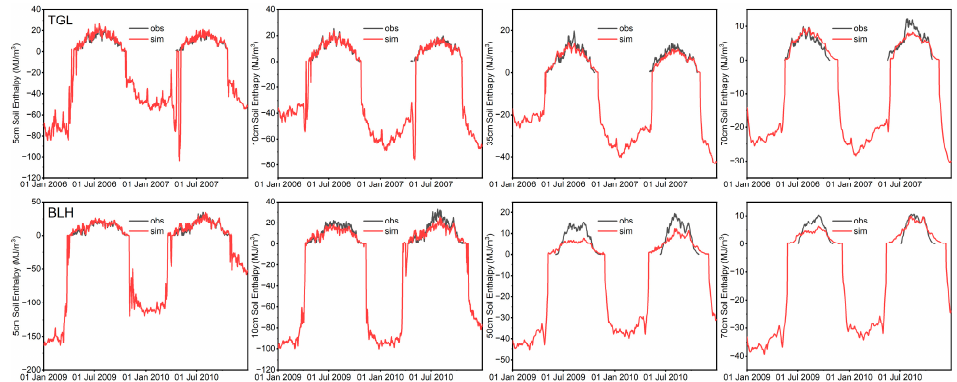
Figure 4. A comparison of the simulated and observed soil enthalpies at various depths at the TGL and BLH sites. Table 4. A comparative analysis of the simulated and observed soil enthalpy at various depths at the TGL and BLH sites.